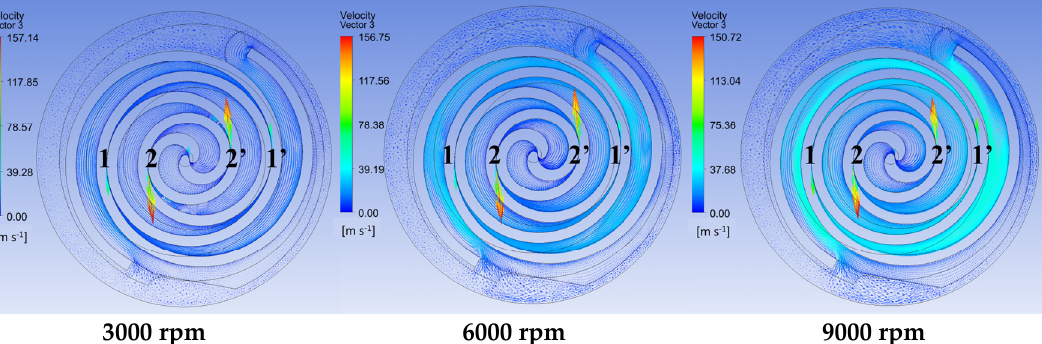
Figure 12. Velocity distribution on a cross-section of the working chamber domain (z = 10.01 mm).